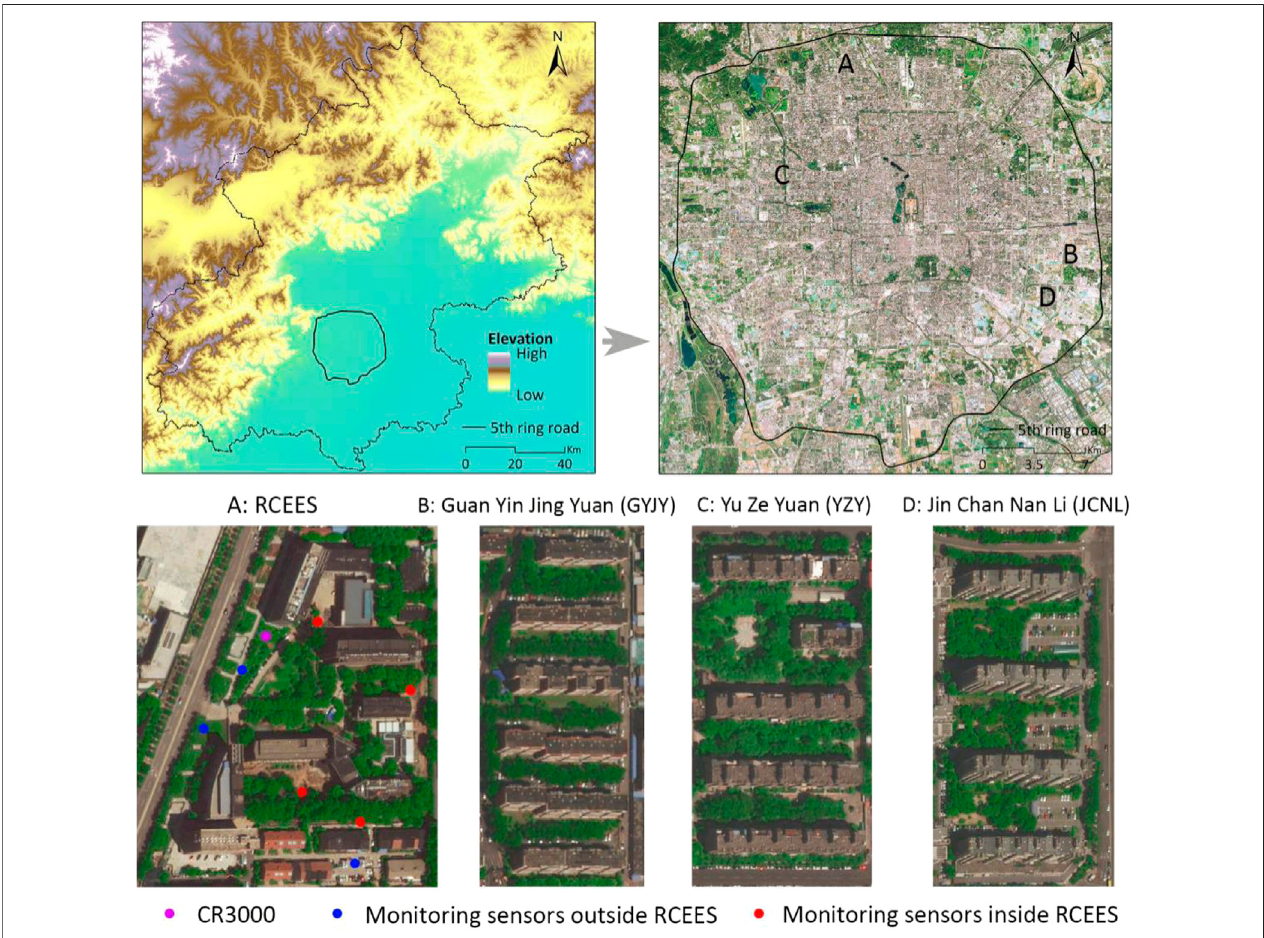
TABLE 1 | Evaluation results of the ENVI-met model performance in RCEES, Beijing.